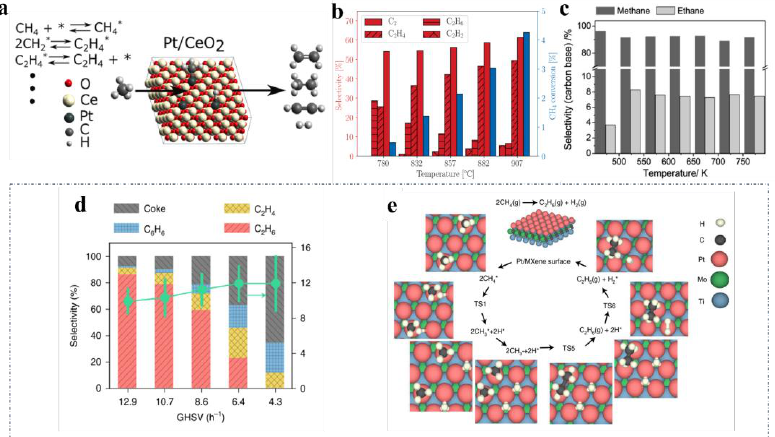
Figure 1. ( a ) Reaction mechanism of Pt/CeO 2 catalyst [17], ( b ) CH 4 conversion and C 2 selectivity on Pt/CeO 2 catalyst [17], copyright 2020, Elsevier. ( c ) Conversion of CH 4 and C-based selectivity to C2 products [18], copyright 2011, Elsevier. ( d ) Catalytic performance of Pt/Mo 2 TiC 2 T x for non-oxidative coupling of CH 4 , and ( e ) a proposed catalytic circle of NOCM over Pt/Mo 2 TiC 2 T x catalyst [19]. Copyright 2021, Springer